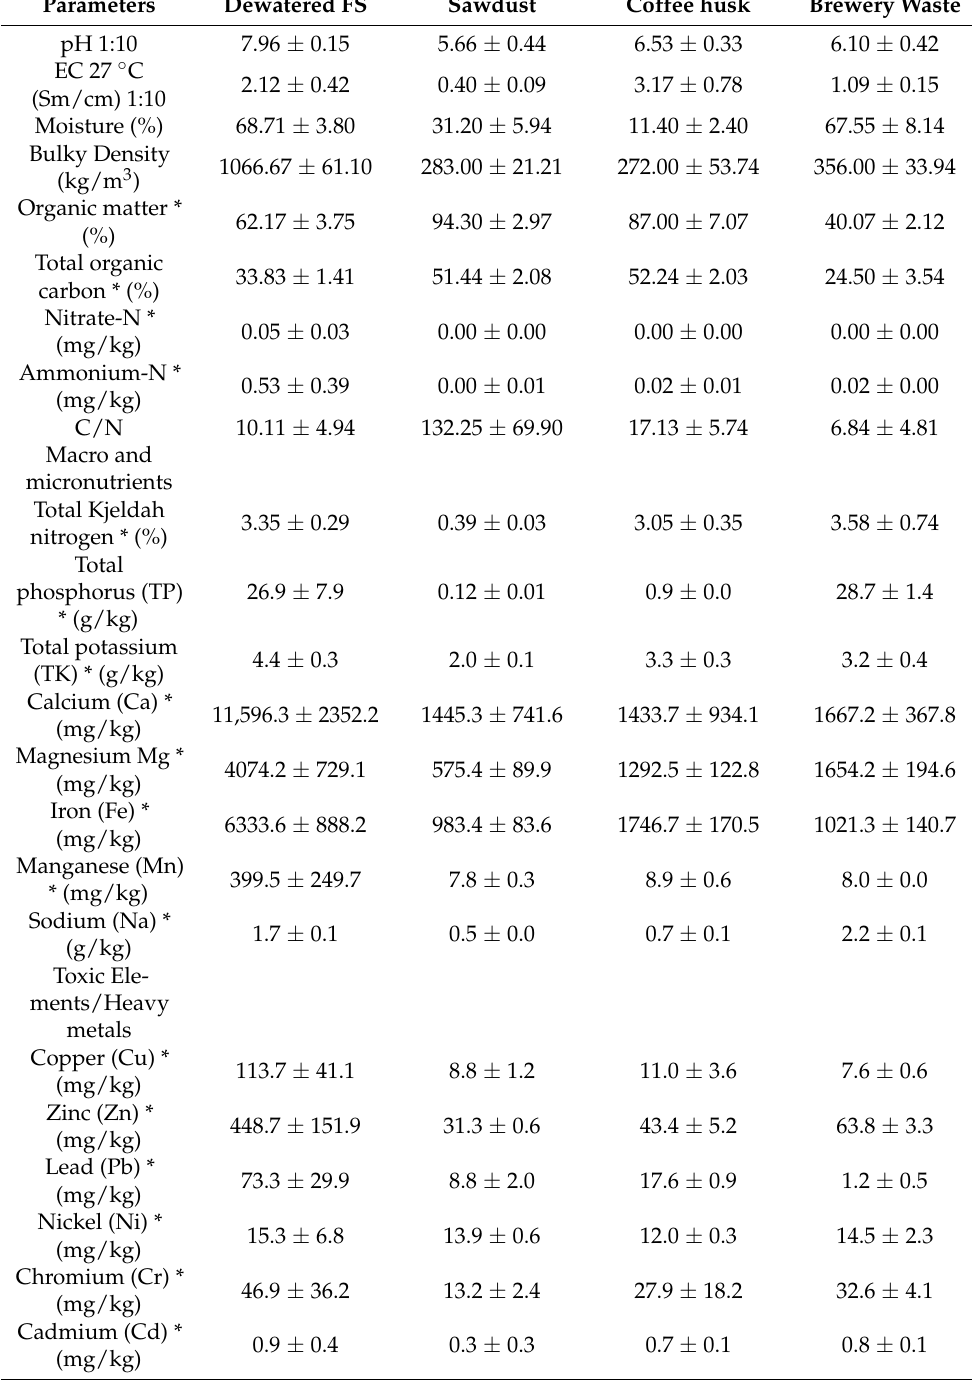
Table 1. Chemical Characteristics of raw material used ‡ .